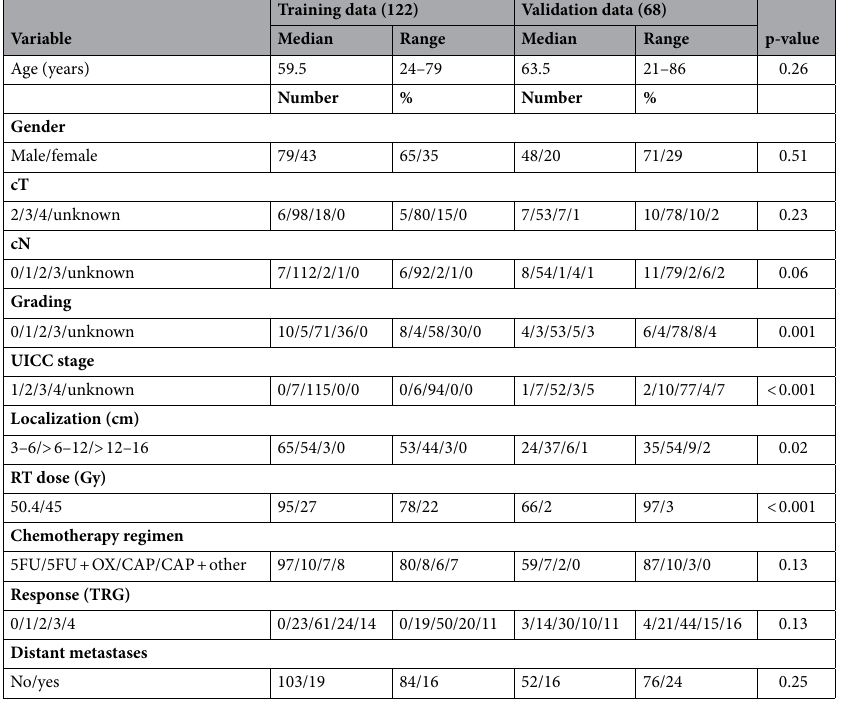
Table 1. Patient, tumour, and treatment characteristics for the training and validation data. cT clinical T stage, cN clinical N stage, RT radiation therapy, TRG tumour regression grade, CAP capecitabine, OX oxaliplatine, FU